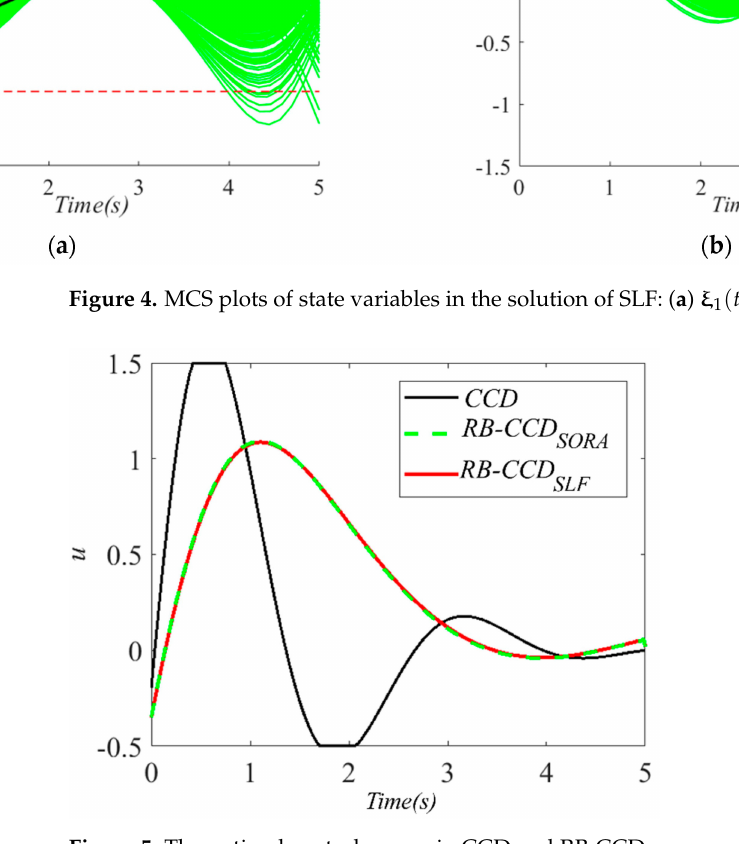
Figure 5. The optimal control curves in CCD and